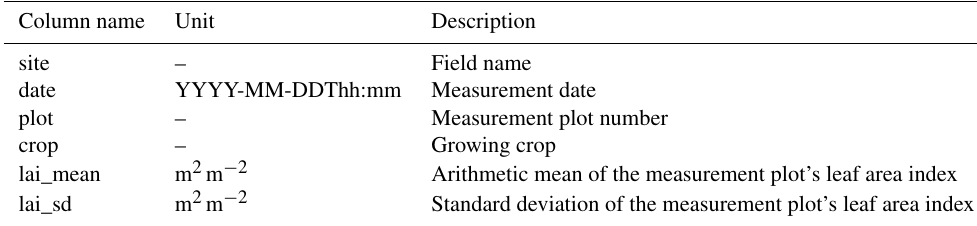
Table 16. Determined leaf area index and data description (lai.csv).